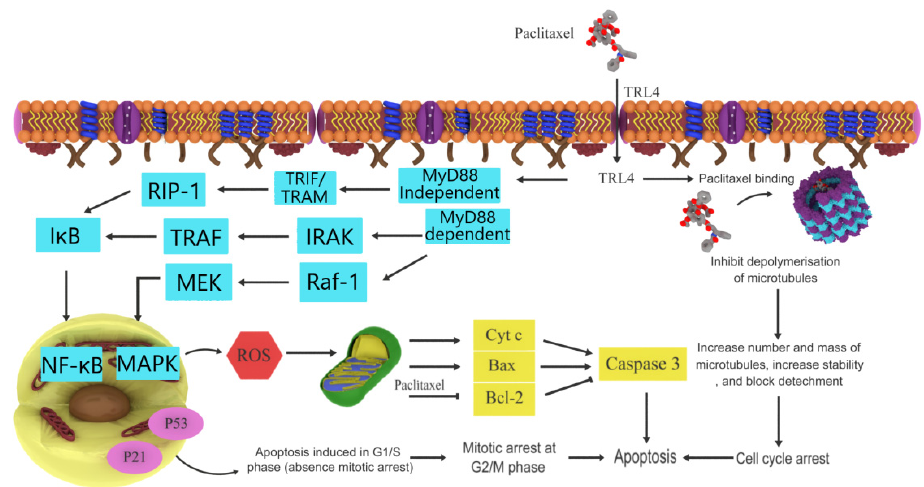
Figure 2. Possible mechanism of paclitaxel action. Paclitaxel targets microtubules and inhibits the depolymerization of microtubules by binding to β -tubulin and leading to cell death. Solute carrier organic anion transporter family member 1B3, which is expressed in various tumors, is the most effective influx transporter for paclitaxel. Paclitaxel induces apoptosis via reactive oxygen species production as well as p21, B-cell lymphoma-2 associated X protein, and caspase overexpression and also activates the Toll-like receptor 4/nuclear factor kappa B pathway. (adopted with modification from [12]).